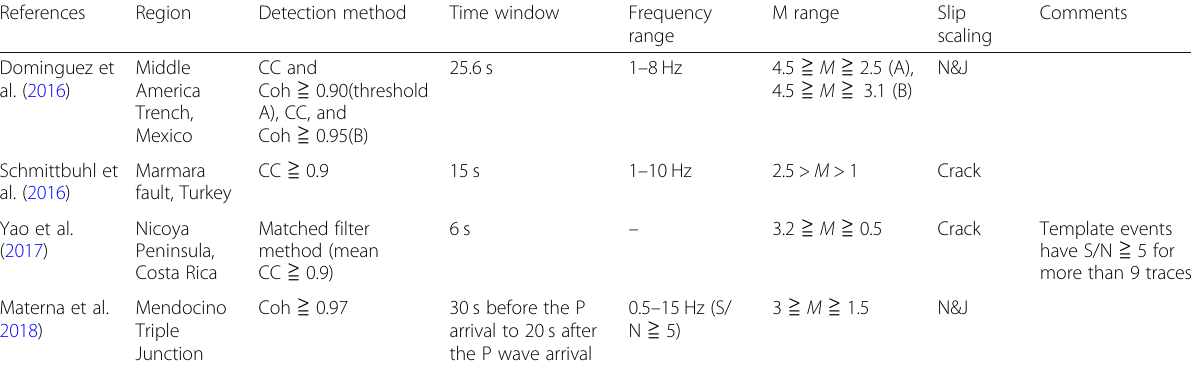
Table 1 Comparison of repeating earthquake selection and slip estimation methods for selected papers